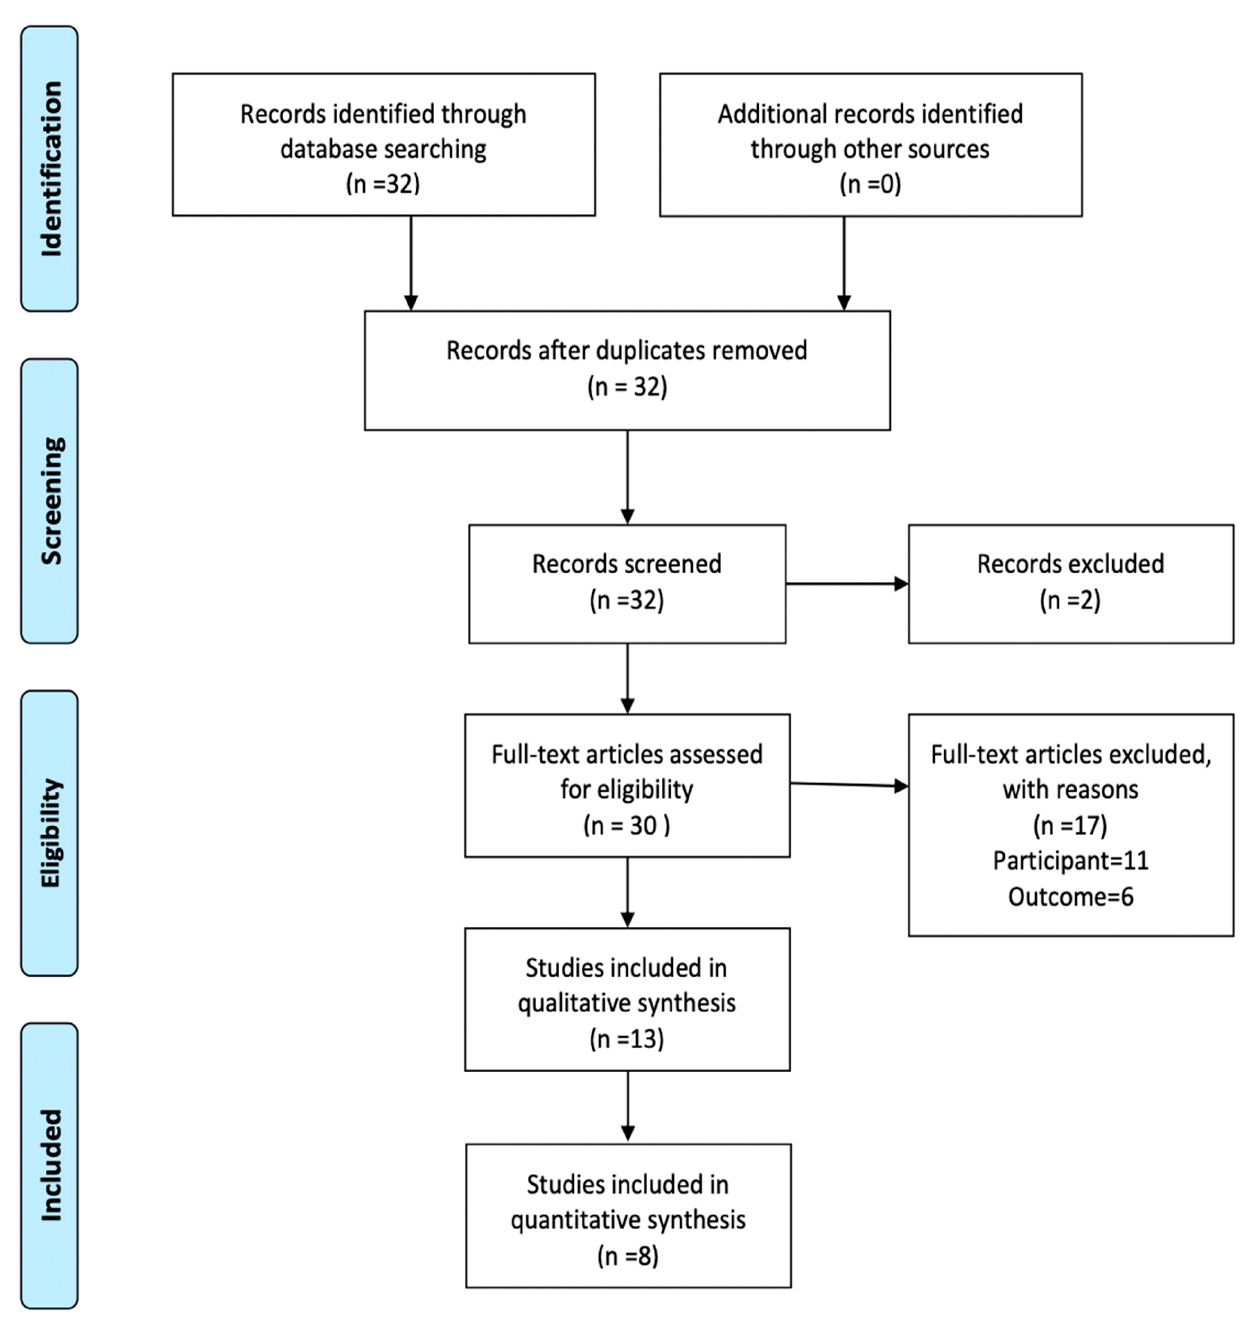
Figure 1. PRISMA study flow.